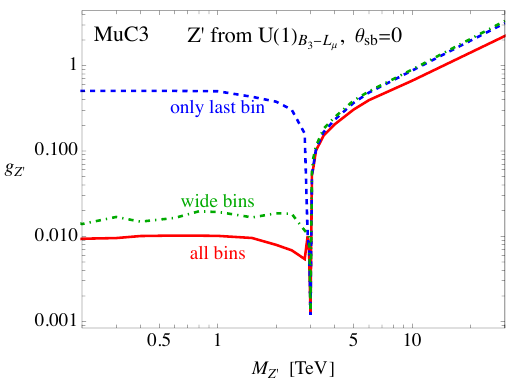
Figure 3 . Comparison of 5 σ discovery prospects for a Z 0 in a gauged U(1) B section 5.1) at MuC3 from µ ¯ µ → jj using the full di-jet resolution (solid red), a few large bins (dot-dashed green), and only the last invariant mass bin (dashed